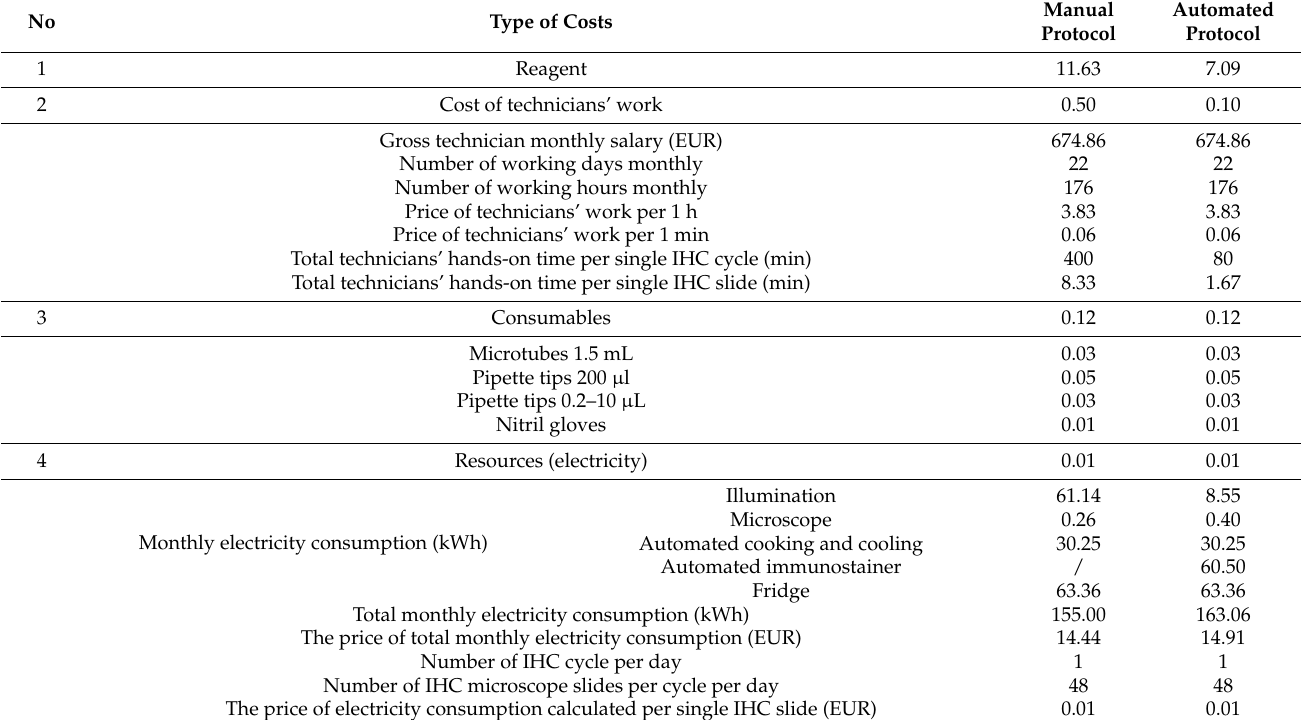
Table 4. Variables that influence final cost (EUR) of a single immunohistochemistry (IHC) microscope slide performed in manual and automated protocols.